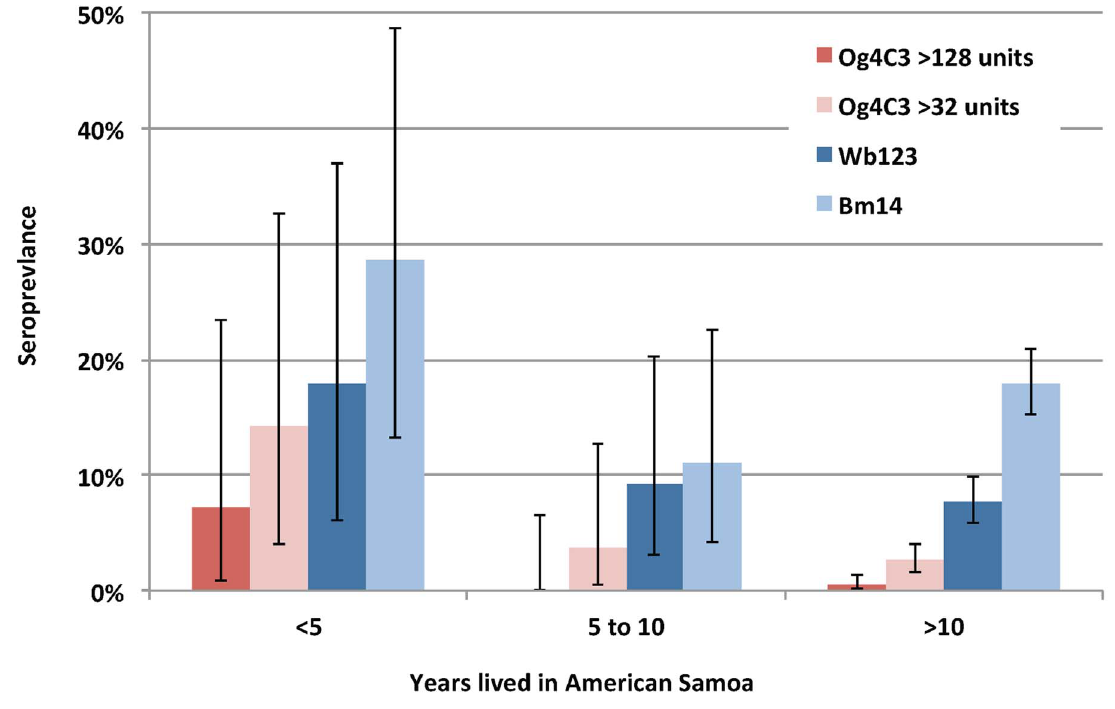
PLOS Neglected Tropical Diseases |